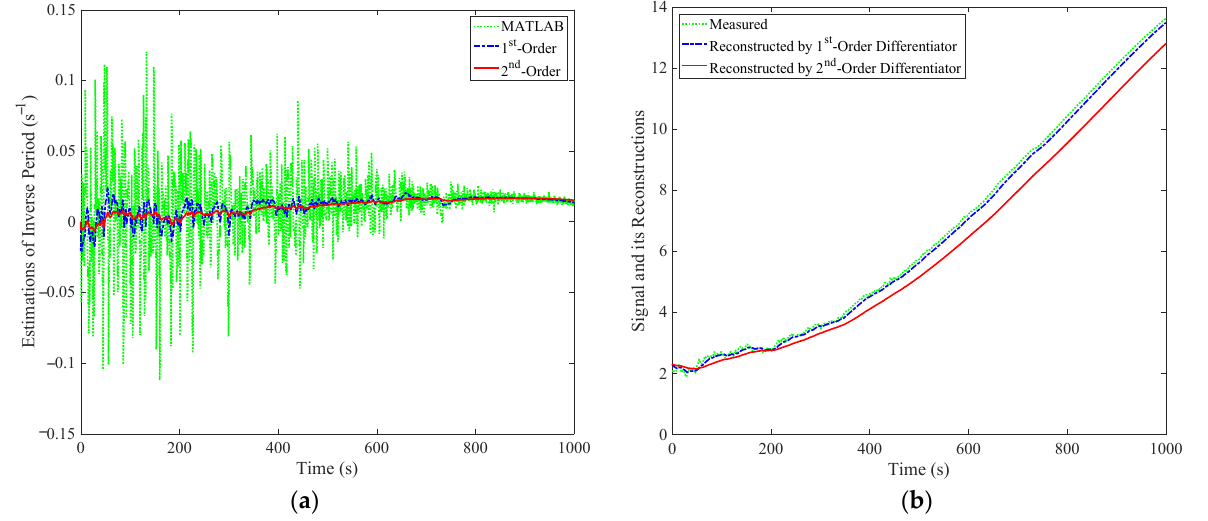
Figure 3. Measurements of inverse period given by different differentiators: ( a ) estimations of inverse period, ( b ) signal and its reconstructions.